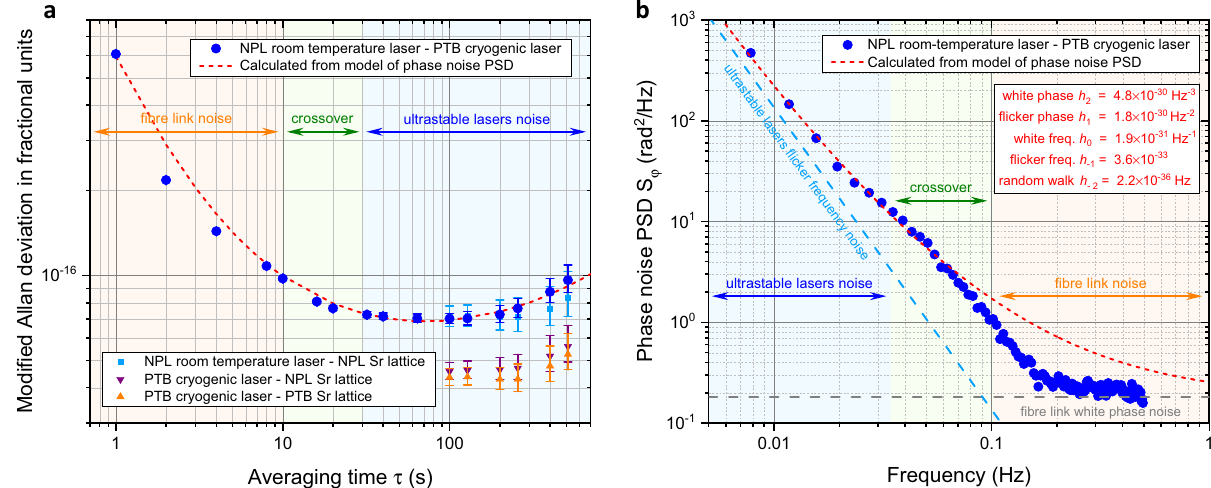
Fig. 2 Experimental results of the comparison of ultrastable lasers through the optical fi bre link. a Combined instability measured comparing the NPL room-temperature laser and PTB cryogenic laser (blue circles) through the 2220 km long European fi bre link network. A linear drift of 40 mHz s − 1 has been removed in the instability evaluation. NPL laser instability evaluated by the NPL strontium lattice clock (cyan squares). PTB laser instability measured by the PTB (orange upwards triangles) and NPL (magenta downwards triangles) strontium lattice clocks. Calculated instability for a simpli fi ed model for the phase noise power spectral density (PSD) (red dashed line). The orange, green and blue shadows highlight the main contributors for the different ranges of integration time, respectively, the fi bre link noise below 10 s, a crossover region from 10 s to 30 s, the noise of the ultrastable lasers above 30 s. The error bars represent the 1 σ uncertainty of the modi fi ed Allan deviation. b Measured ensemble phase noise of the ultrastable lasers at PTB and NPL and the fi bre link (blue circles). No information about the link noise is available for frequencies above 0.5 Hz since the measurements are based on dead-time-free Λ -counted data with report interval of 1 s. The blue, green and orange shadows highlight the main contributors for the different ranges of frequencies, respectively, the ultrastable lasers noise below 30 mHz, a crossover region from 30 mHz to 100 mHz, the fi bre link noise above 100 mHz.